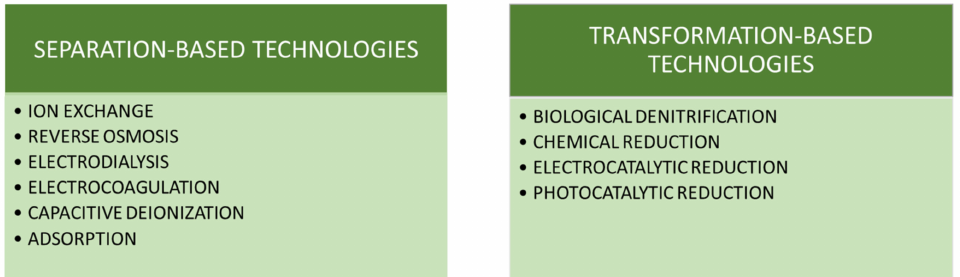
Figure 2. Main technologies for nitrate removal in